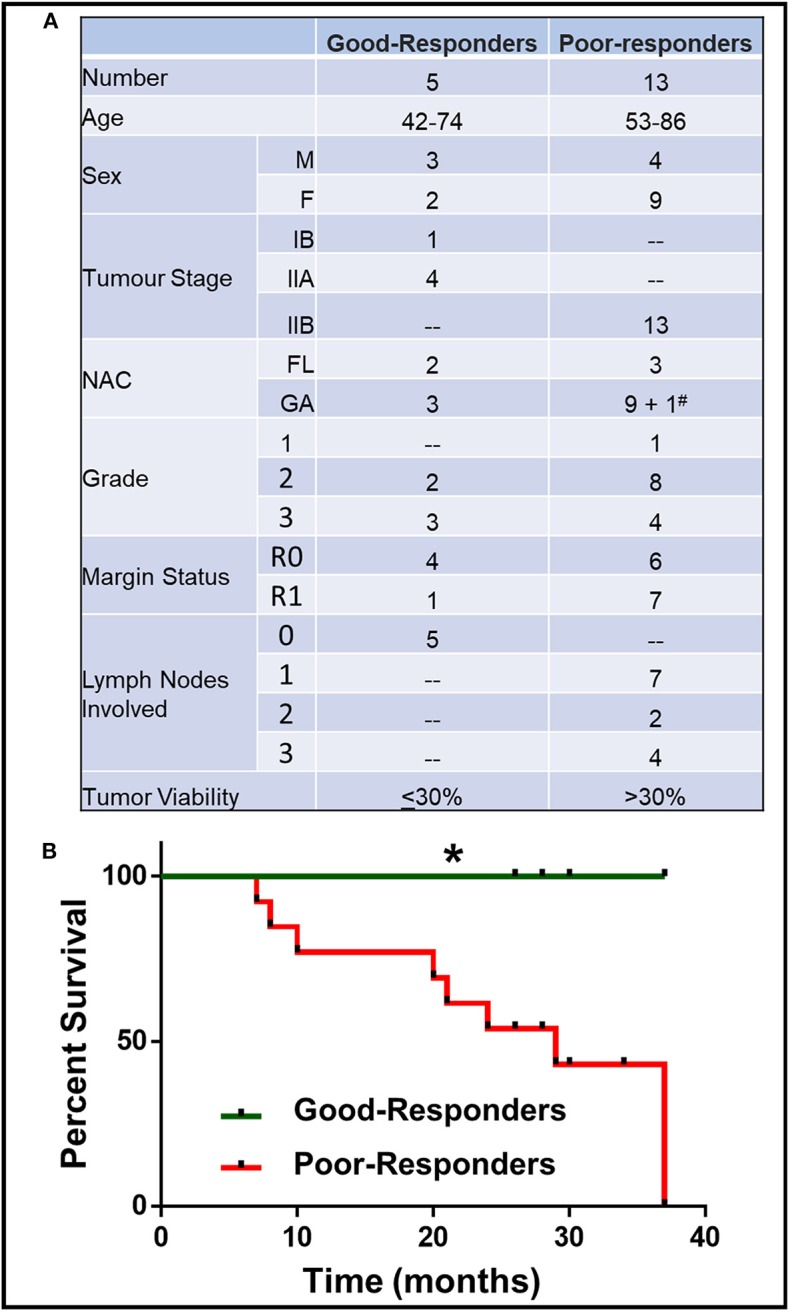
Characteristics of patient with good and poor NAC response. (A) Details of patient age, sex, tumor stage, grade, margin status, number of lymph nodes involved, neoadjuvant chemotherapy (NAC) received (FL, Florfirinox; GA, Gemcitabine/Abraxane; #Patient initially received FL followed by GA) and residual tumor cell viability. (B) Kaplan-Meier survival curve for good- and poor-NAC responders. *p < 0.05.